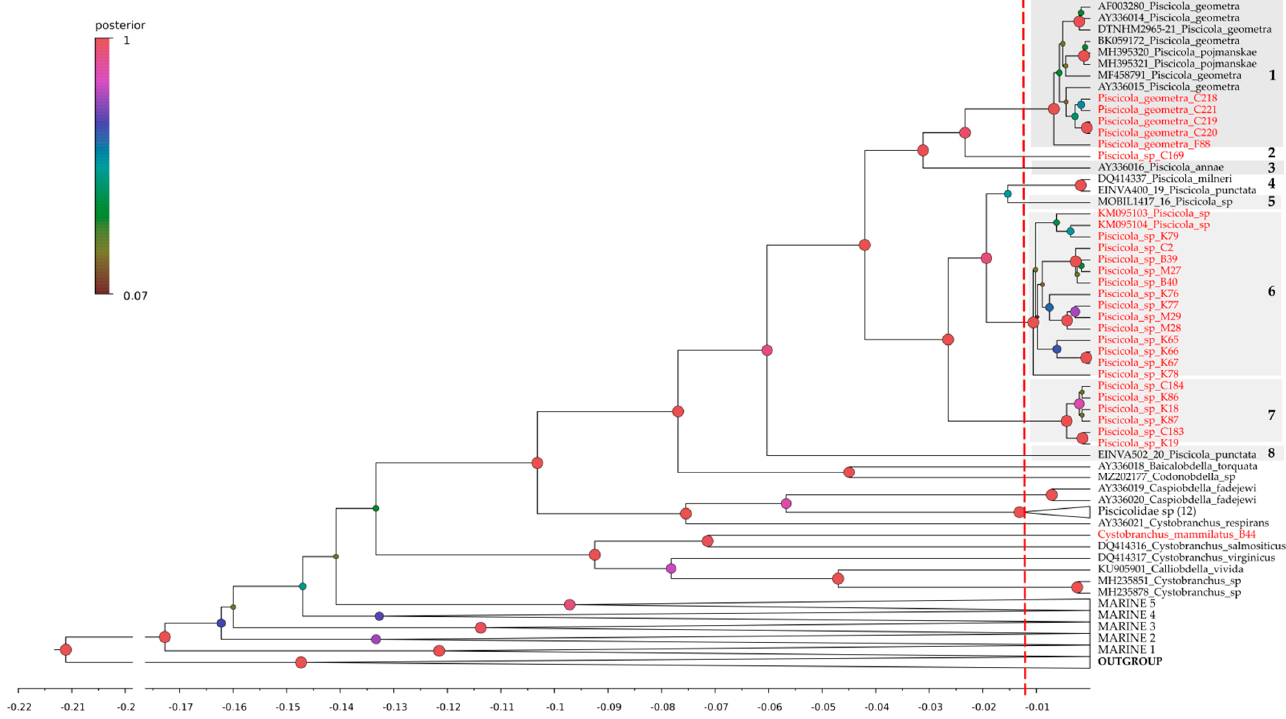
Figure 2. Bayesian tree based on the barcoding genome fragment alignment of 116 Hirudinea specimens, including data on 81 freshwater and marine piscine leeches and 7 glossiphoniids, which were used as comparison group and outgroup, respectively. Tip labels of the 28 cox1 sequences assembled in this work are colored in red. The red dotted line indicates the threshold separating intra- and interspecies variability.